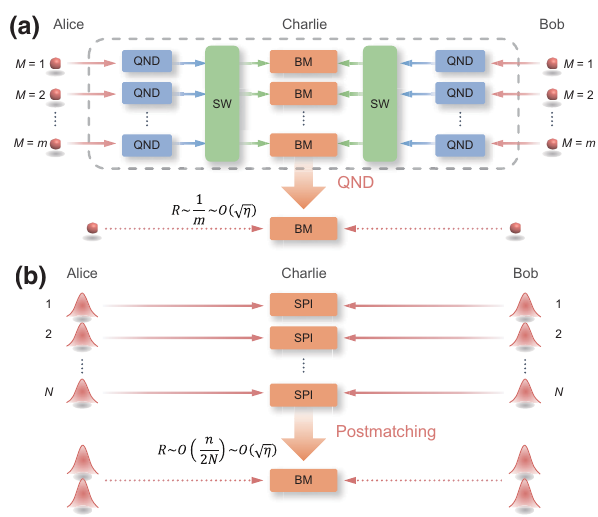
FIG. 1. Basic idea of the adaptive MDIQKD scheme [83] and this work. (a) In the adaptive MDIQKD scheme, Alice and Bob send m single-photon pulses to Charlie using spatial mul- tiplexing. Charlie applies quantum nondemolition (QND) mea- surement to confirm the arrival of pulses, matches the arriving pulses using optical switches (SWs), and performs two-photon Bell measurements (BMs) on the pairs. (b) In our asynchronous- MDIQKD protocol, Alice and Bob send N pulses to Charlie to perform single-photon interference (SPI), and a two-photon Bell state is obtained by postmatching two successful SPI events.